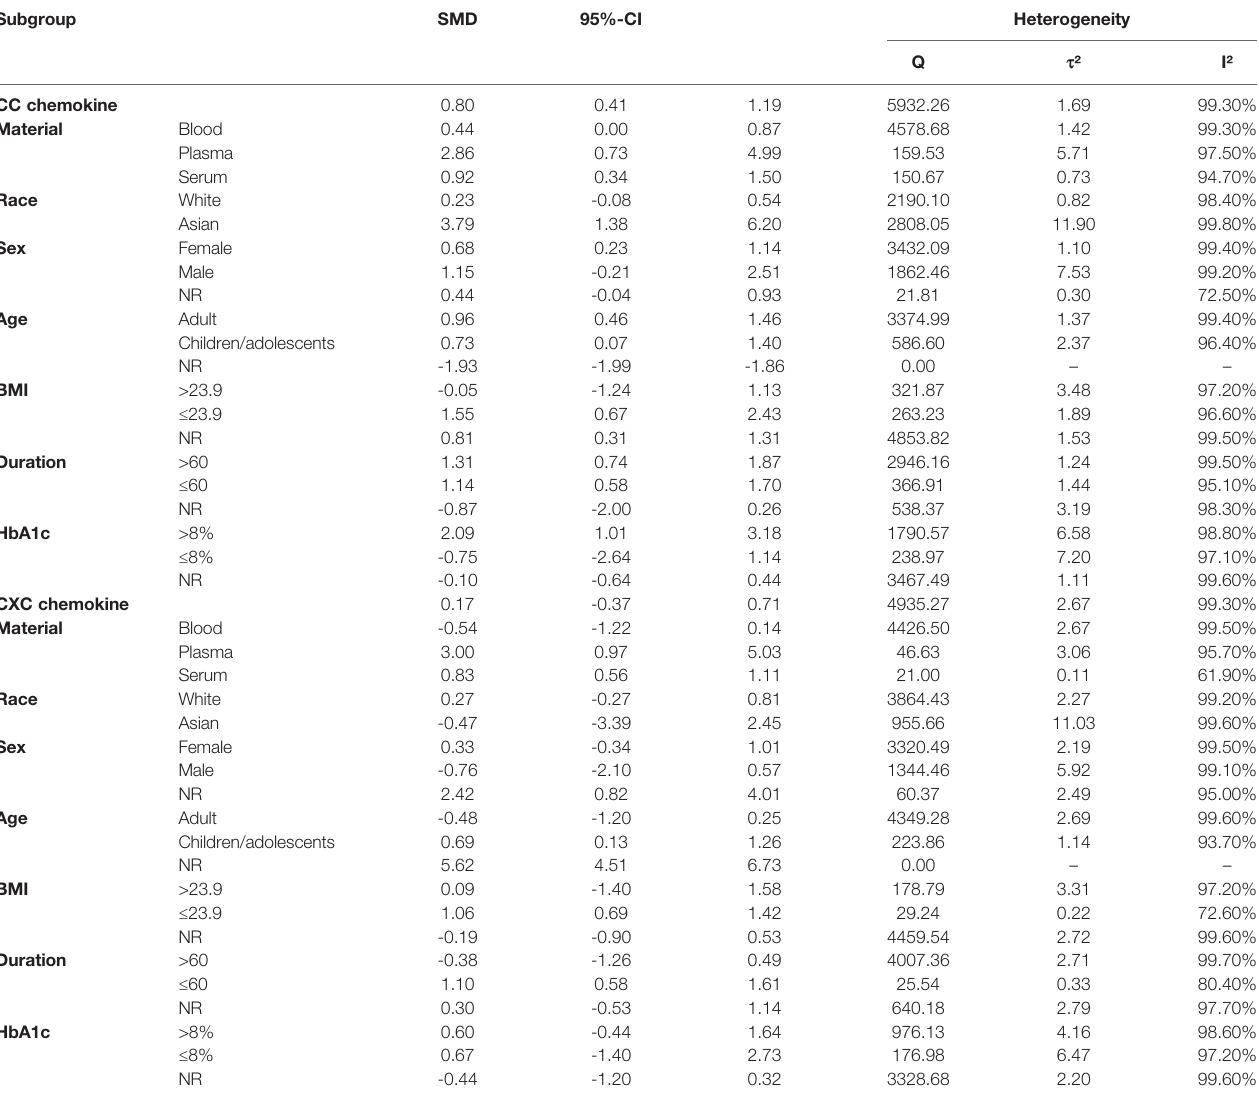
TABLE 2 | Subgroup analysis of CC and CXC chemokine between T1DM participants and controls. Subgroup SMD 95%-CI Heterogeneity